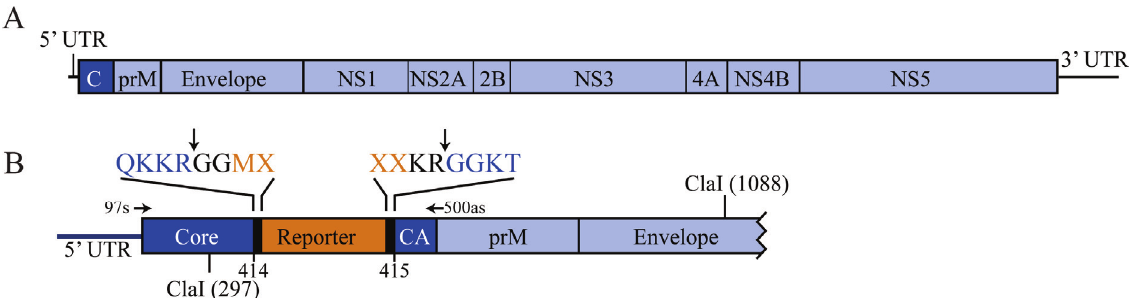
Figure 1. Schematic of West Nile virus-New York (WNV-NY) reporter viruses. ( A ) WNV genome. A scale representation of the WNV genome is shown. The arrangement of the 5’ and 3’ untranslated regions and the ten genes are indicated; ( B ) WNV-NY reporter viruses. Reporter genes (orange) were inserted between nucleotides (nts) 414 and 415 (Capsid (C)/Capsid Anchor (CA) junction) of WNV-NY (blue). Heavy black bars represent additional nts that form the engineered WNV-NS2B/NS3 protease cleavage sites; -P ’ residues and site of protease cleavage ( ↓ ) are indicated at the top, where X the P 4 4 represents variable amino acids. The location of the two ClaI sites used in the generation of the reporter-containing pA constructs is also shown, as are the annealing sites